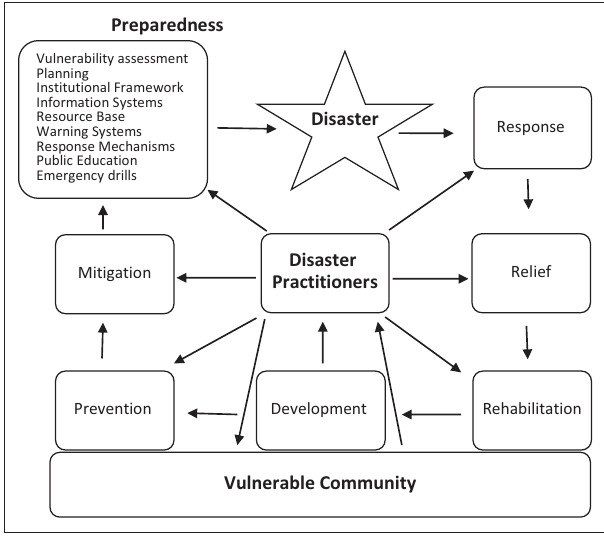
FIGURE 8: Community-based disaster risk reduction